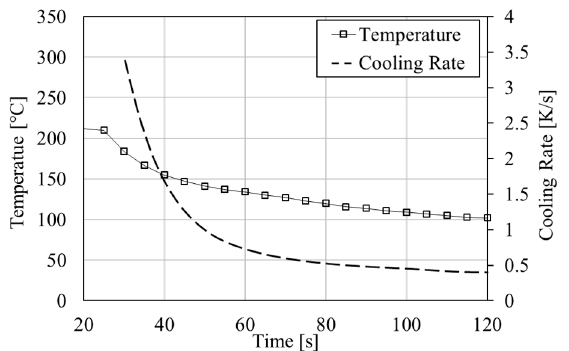
Figure 1. Temperature (solid squares) and cooling rate (dashed) during sample casting Sn-20 wt.% Bi sample.